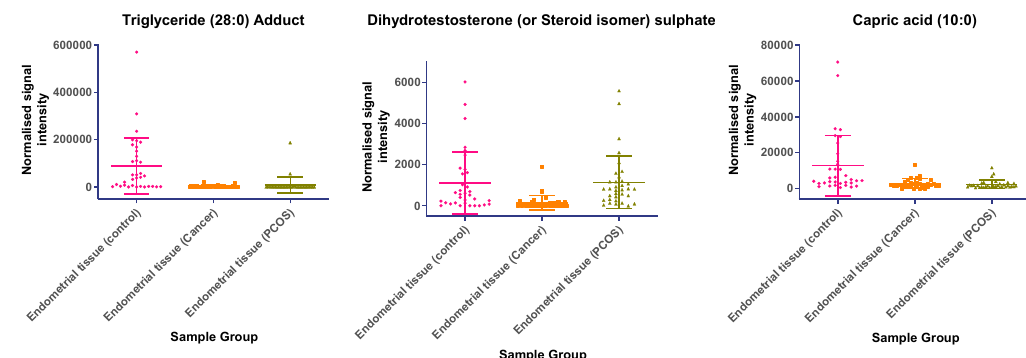
Figure 6. ( a ) Compounds that significantly increase in concentration in the endometrial cancer group; ( b ) Compounds that significantly decrease in concentration in the endometrial cancer group. Scatter dot plots of example potential biomarkers in endometrial tissue samples. All shown biomarkers fulfil criteria of both multivariate analysis (MVA) and univariate analysis (UVA). MVA criteria were a Variable Importance Projection (VIP) value > 1 in the OPLS-DA model shown in Figure 1. Criteria for UVA were a q ‐ value < 0.05 (control vs. endometrial cancer only), for all control vs. EC, Q > 0.05 and a fold change <0.8 or >1.2. Dots show the normalised intensity metabolites from control endometrial cancer and PCOS tissue samples ( n = 34),